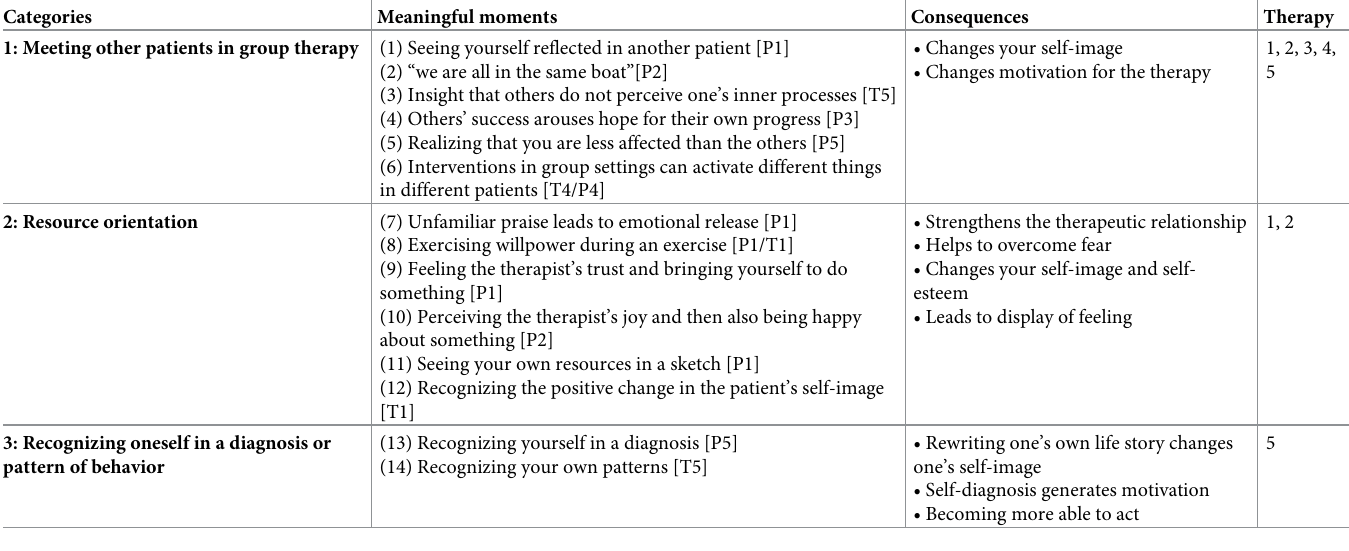
Table 2. Categories and meaningful